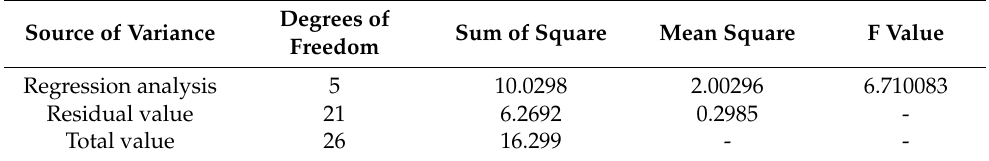
Table 5. ANOVA table of micro texture life cycle. Degrees of Source of Variance Sum of Square Mean Square F Value Freedom Regression analysis 5 10.0298 2.00296 6.710083 Residual value 21 6.2692 0.2985 - Total value 26 16.299 -